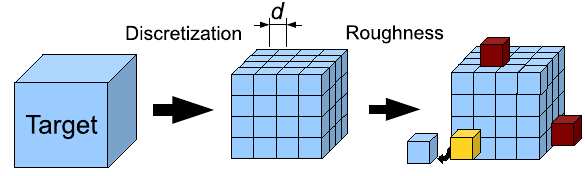
Figure 1: The basic idea of DDA: discretizing the target in a set of dipoles, and roughness control.